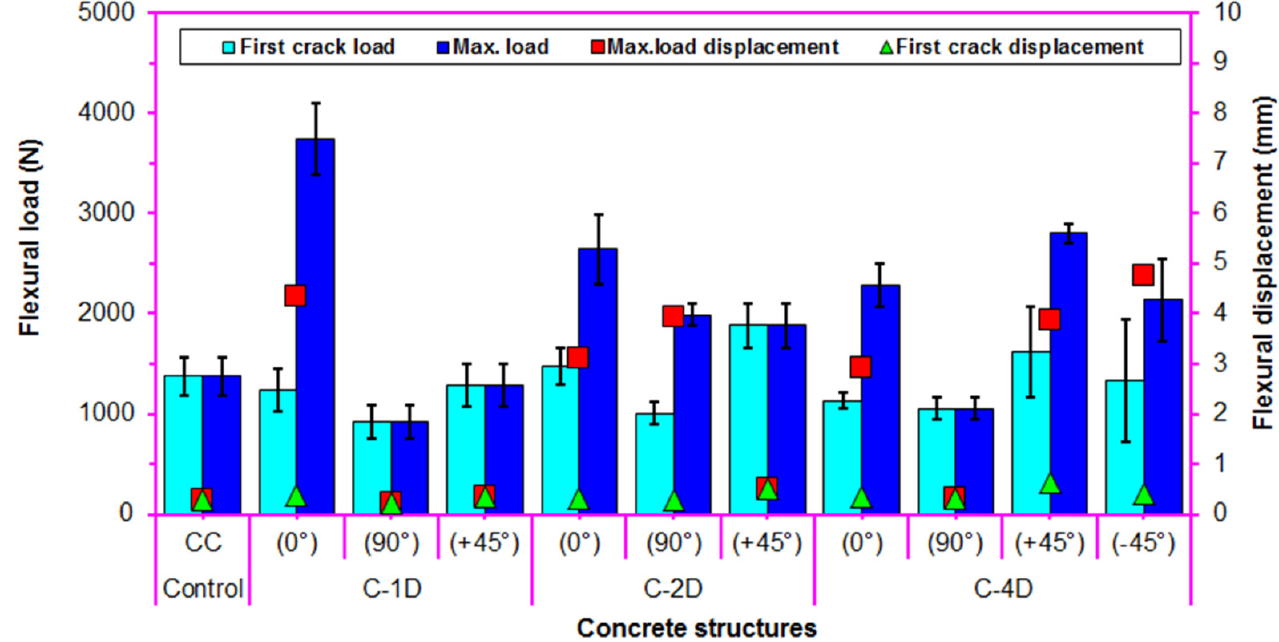
Figure 11. Average maximum and first crack load-displacements for multiaxis 3D carbon fiber concrete.